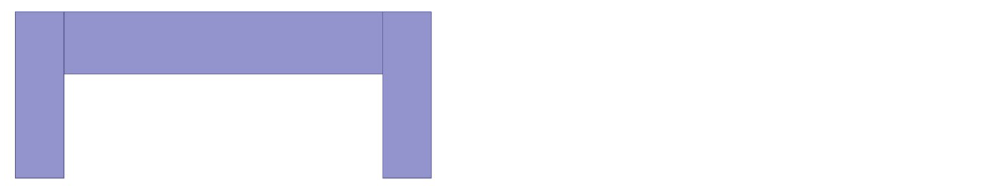
Figure 11. Cross section of type-I rail.